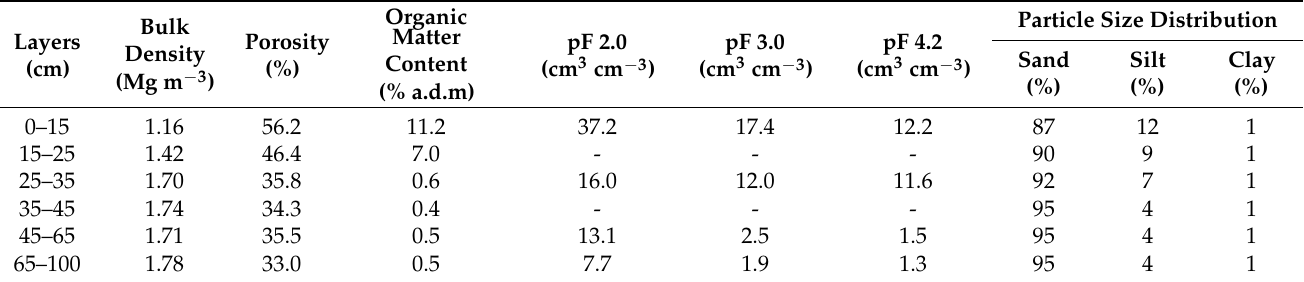
Table 1. Basic soil properties of the investigated soil